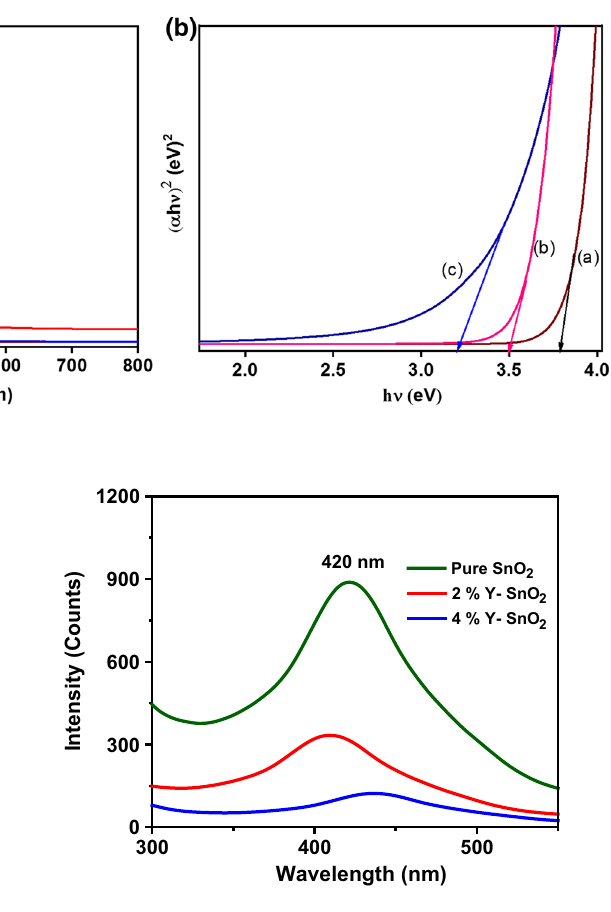
Fig. 6 PL spectra of (a) SnO 2 , (b) 2% Y-doped SnO 2 NPs and (c) 4% Y-doped SnO 2